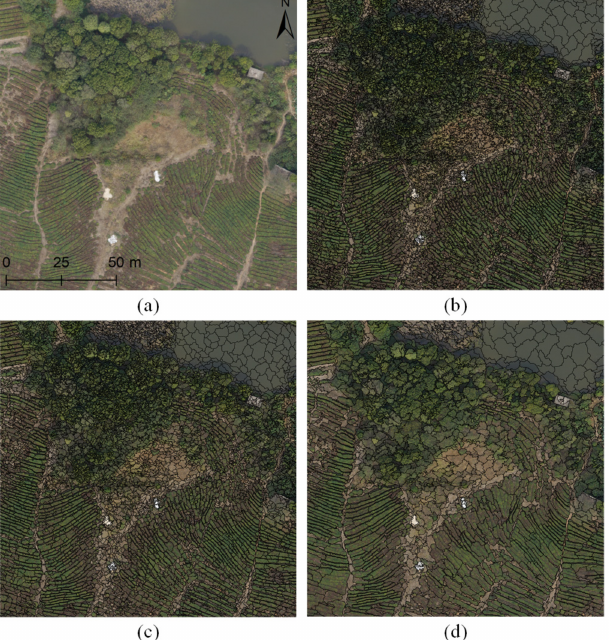
Figure 5. Comparison of the image segmentation levels in the study area. ( a ) Digital image of the sample at 0.1 m resolution; ( b ) image segmentation with MRS scale 20 (Shape/Color: 0.1/0.9); ( c ) image segmentation with MRS scale 20 (Shape/Color: 0.3/0.7); ( d ) image segmentation with MRS scale 40 (Shape/Color: 0.3/0.7). Table 3. List of features derived from UAV digital imagery. Feature Implication Spectral mean values